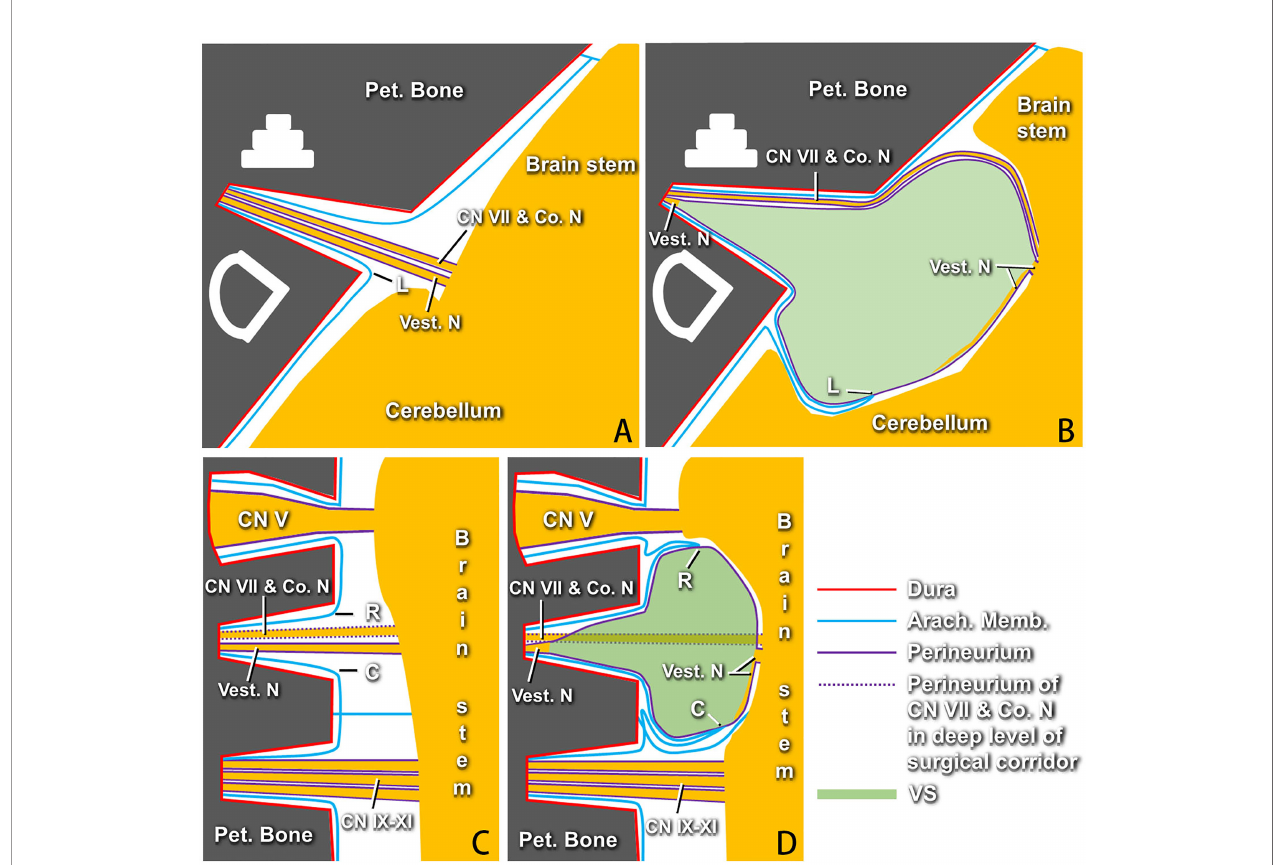
FIGURE 2 | Models of membranous structures around vestibular schwannomas (VSs) proposed by the authors according to the surgical fi ndings ( right side ). (A) Axial section showing the facial nerve, cochlear nerve, and vestibular nerves, which are covered with perineurium, running from the brainstem into the internal acoustic canal (IAC) fundus under the arachnid membrane in the normal situation. Point “ L ” indicates the arachnoid membrane at the lateral point of the IAC porus. (B) Axial section showing the arachnoid membrane at point “ L ” being adhered and stretched by the tumor to the cerebellopontine angle (CPA) with the progress of VSs, which causes “ three arachnoid layers ” on the lateral surface of the perineurium-covered tumor anterior to the dislocated point “ L . ” The site of point “ L ” pulled by the tumor to the CPA is different for each case. There remain some degenerated vestibular nerve fi bers that can be identi fi ed between the perineurium and the tumor, as well as the IAC fundus. (C) Coronal section showing the normal pro fi le of membranous structures at the rostral and caudal sides of cranial nerves (CNs) VII and VIII. Points “ R ” and “ C ” represent the arachnoid membrane at the rostral and caudal points of the IAC porus, respectively. (D) Membranous structures between the VSs and CN V or CN IX – XI varying greatly at different sites due to the different dislocations of points “ R ” and “ C . ” The innermost layer of the perineurium can be identi fi ed constantly around the tumor. Pet ., petrous; Co. N , cochlear nerve; Vest. N , vestibular nerve; Arach ., arachnoid; Memb ., membrane; VSs , vestibular